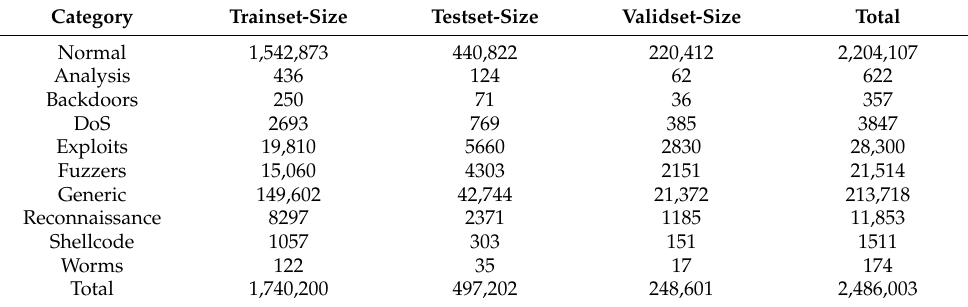
Table 2. UNSW-NB15 Dataset Description.